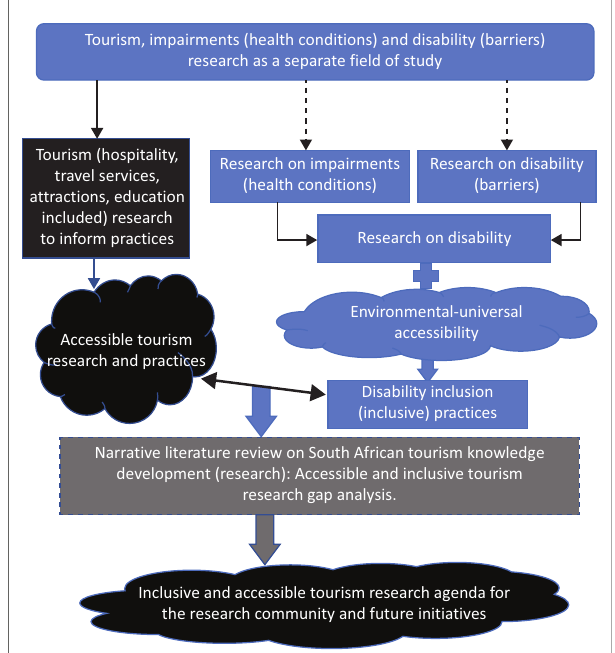
FIGURE 1: Conceptual framework for the